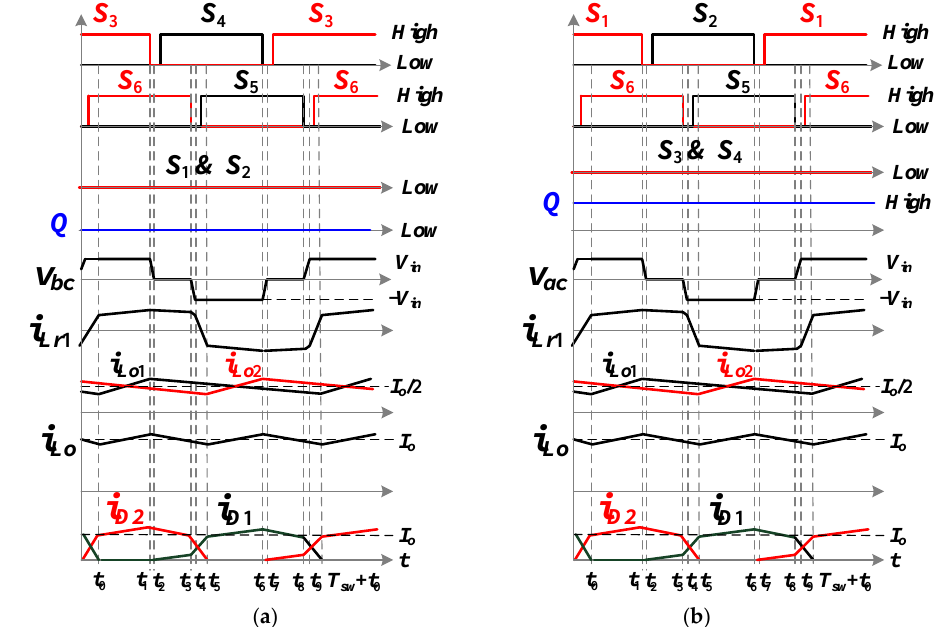
Figure 2. Pulse-width modulation (PWM) singles in the ( a ) low voltage input range; ( b ) high voltage input range.